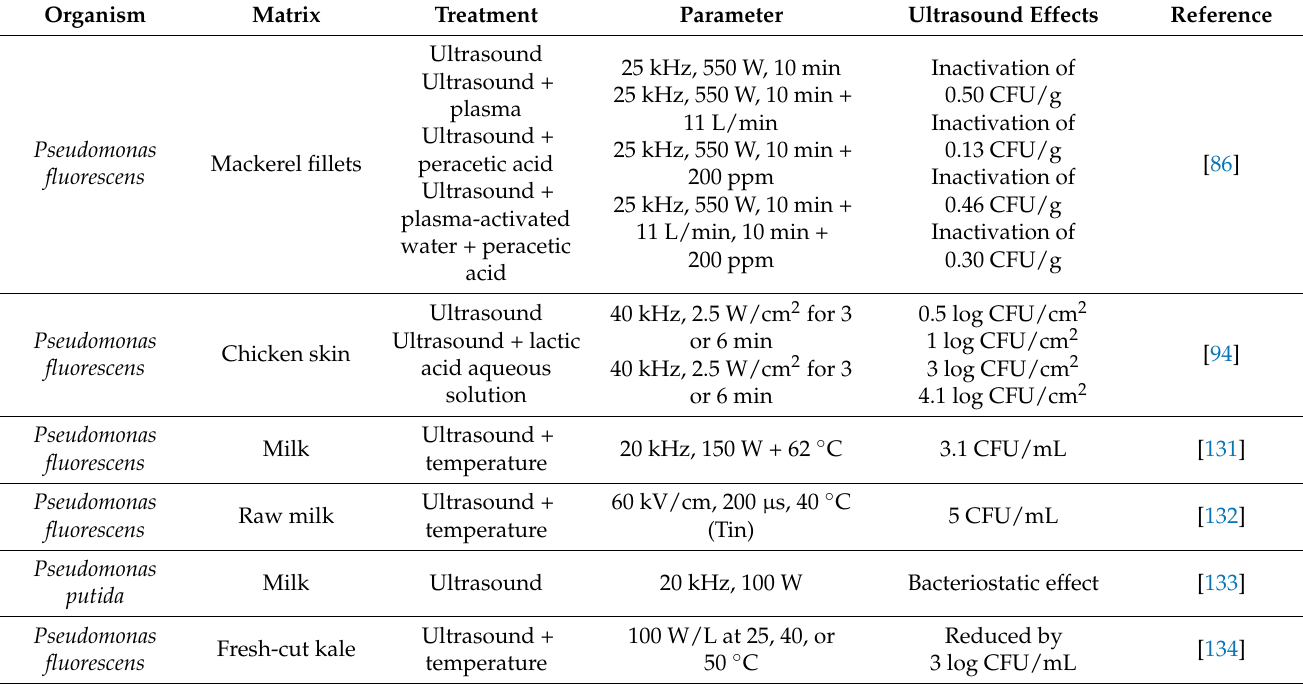
Table 8. Ultrasound effects as single or combined non-thermal technology: Pseudomonas